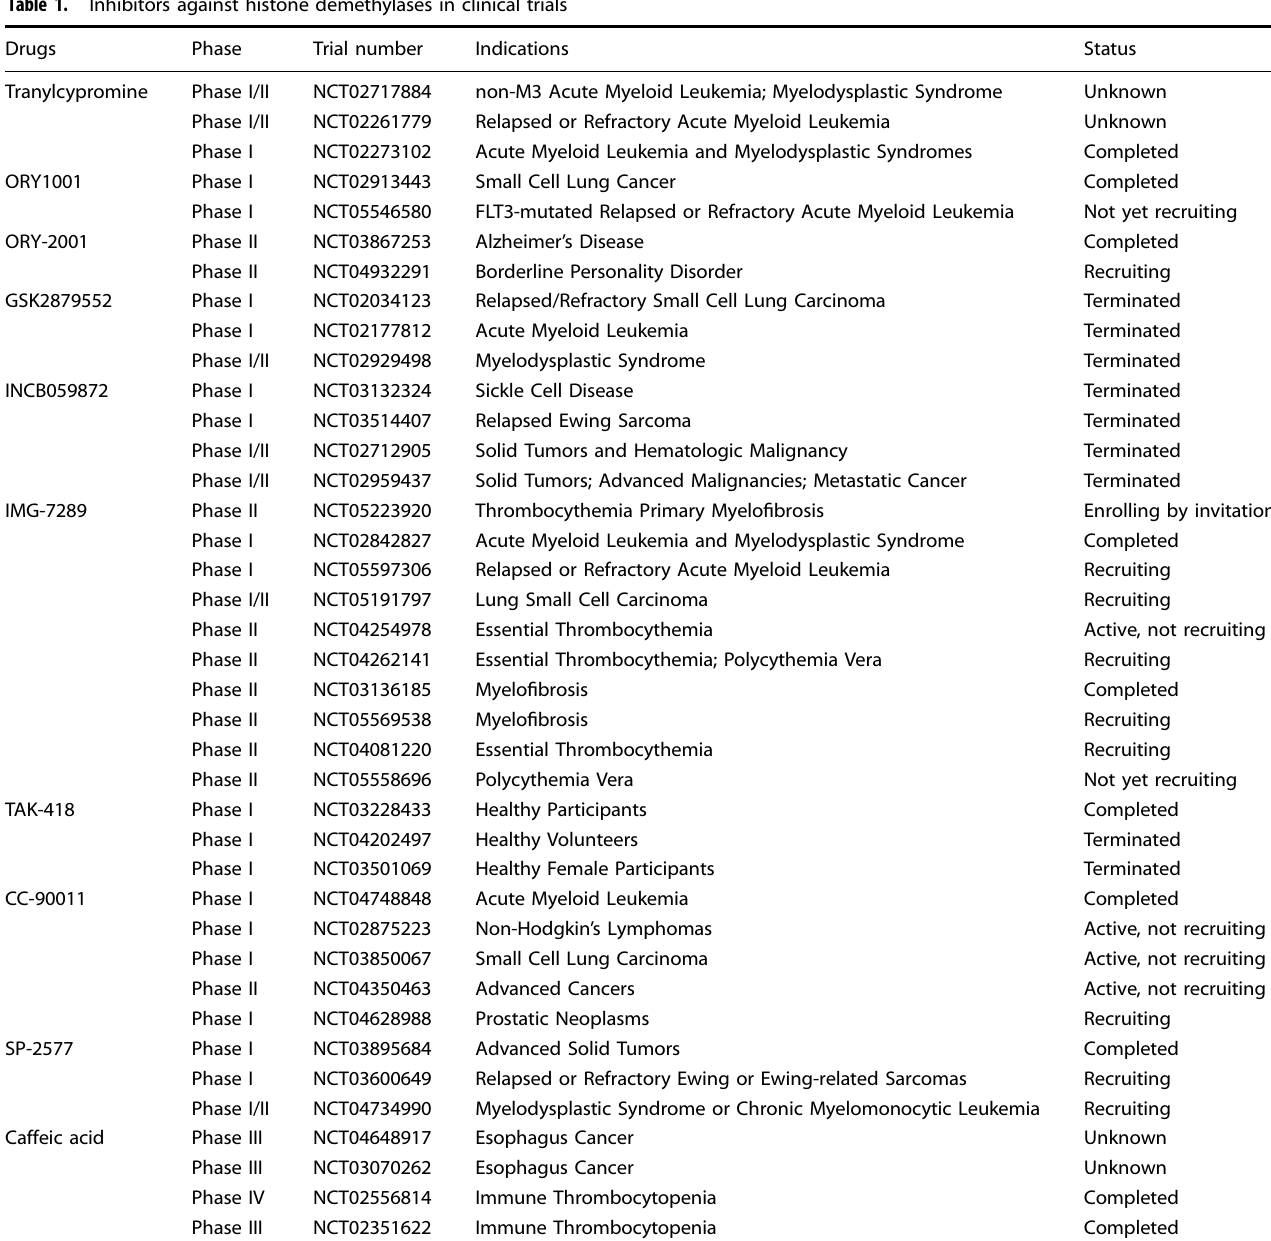
Table 1. Inhibitors against histone demethylases in clinical trials